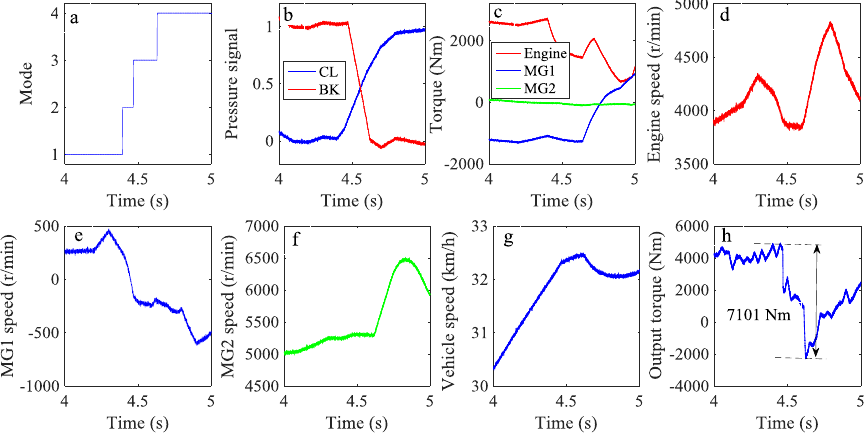
Figure 18. Experimental results of the hybrid HDV without control. ( a ) Mode; ( b ) Pressure signal; ( c ) Torques of Engine and MGs; ( d ) Engine speed; ( e ) MG1 speed; ( f ) MG2 speed; ( g ) Vehicle speed; and ( h ) Output torque.